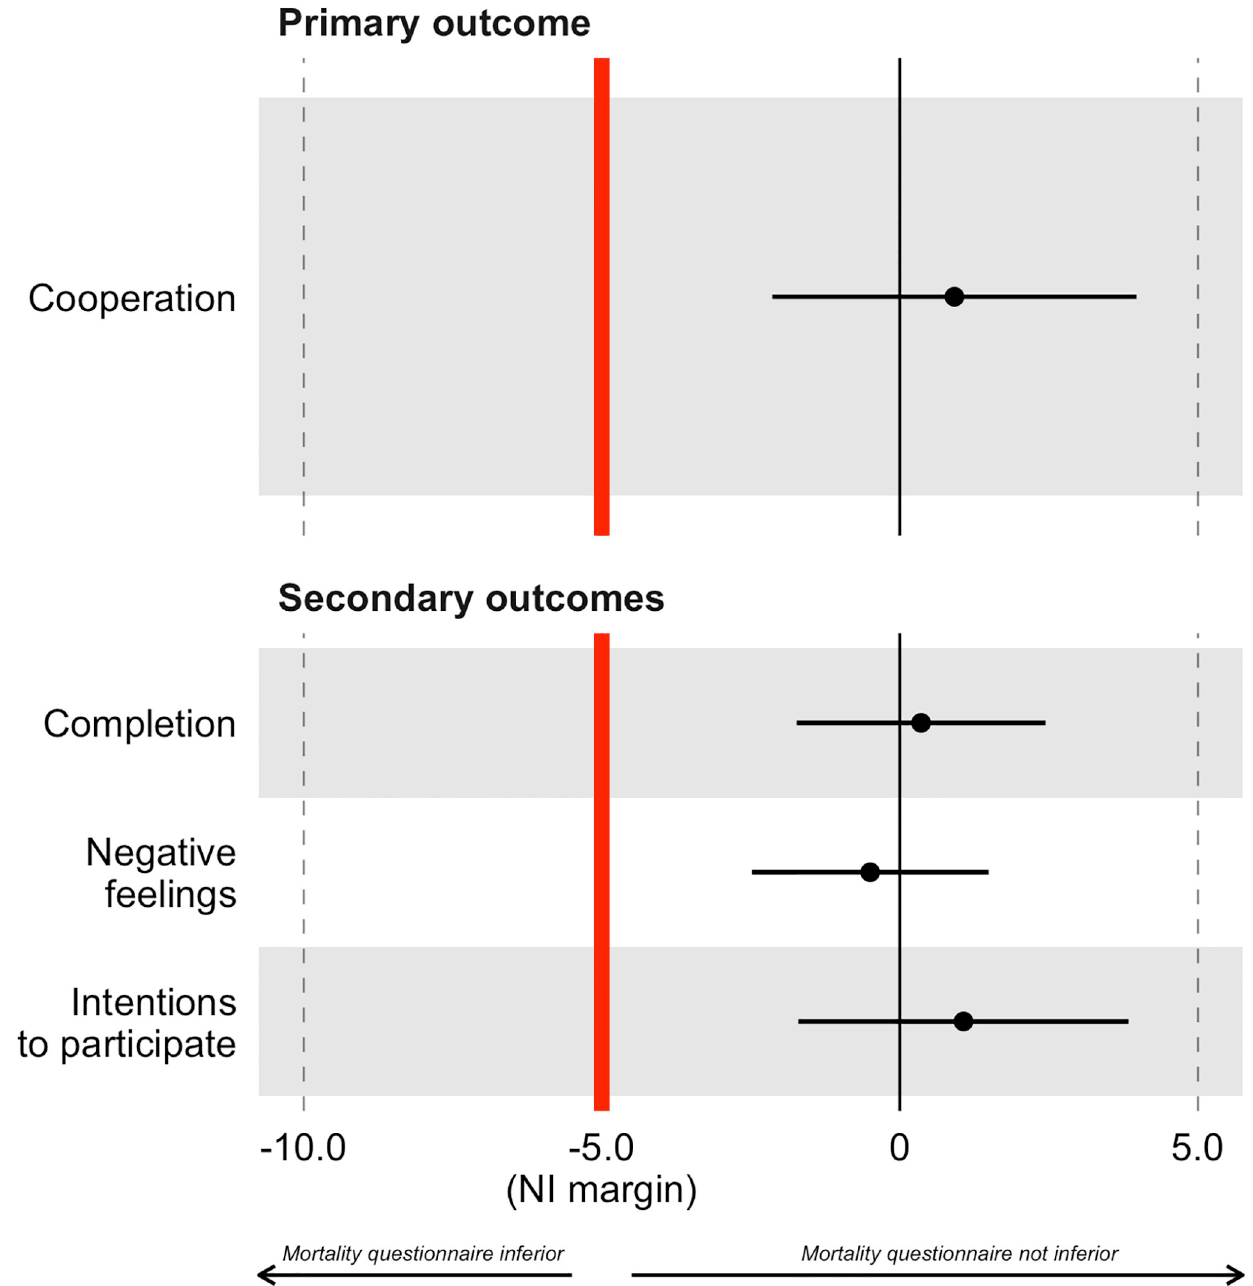
Fig 3. Differences in study outcomes between mortality and economic questionnaires. Notes: Values of the x-axis are expressed in percentage points. They are calculated as % in the group allocated to the mortality questionnaire, minus the % in the group allocated to the economic questionnaire. Error bars represent two-sided 95% confidence intervals around the difference in proportions between study groups. The non-inferiority criterion is met when the confidence interval remains to the right of the non-inferiority margin (red vertical line). Similar results were obtained when calculating one-sided confidence intervals. NI =